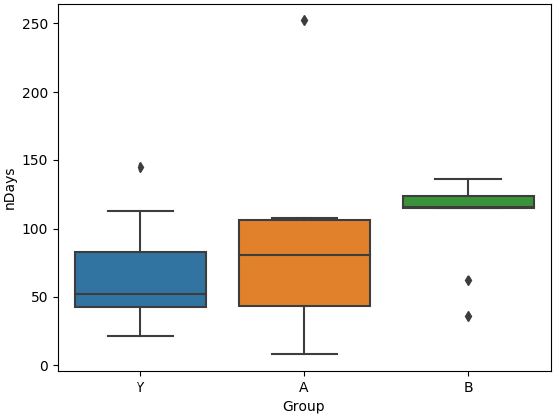
Figure 6. Box plots for time series length for each group.